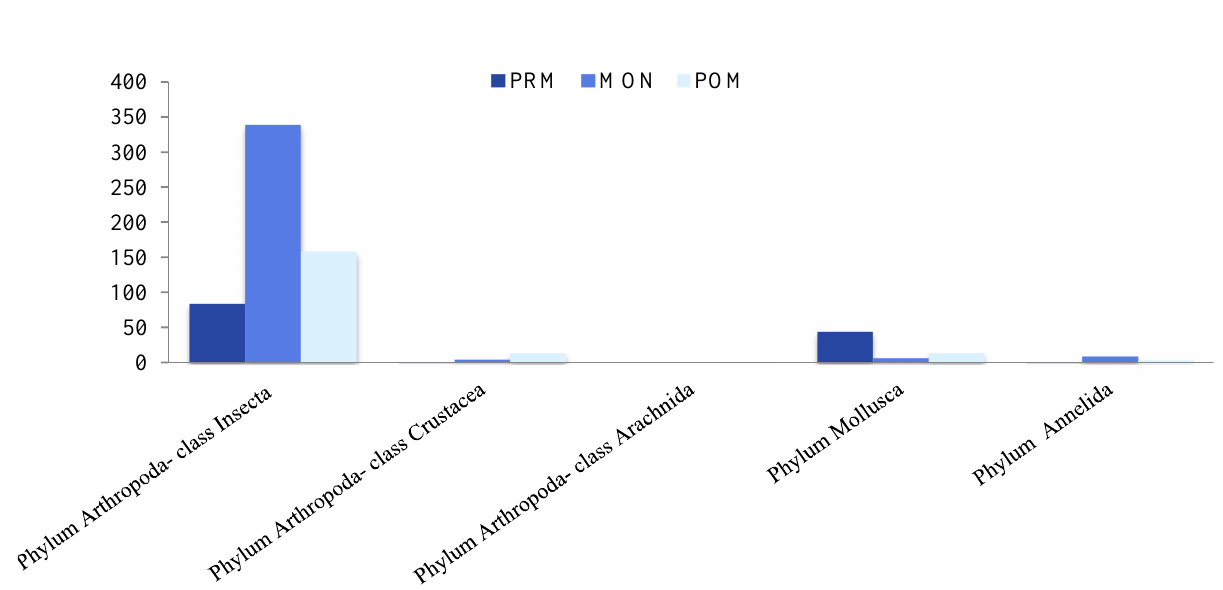
Figure 6. Variations in numbers of macroinvertebrates grouped in phyla in a year PRM: Premonsoon; MON: Monsoon; POM: Postmonsoon